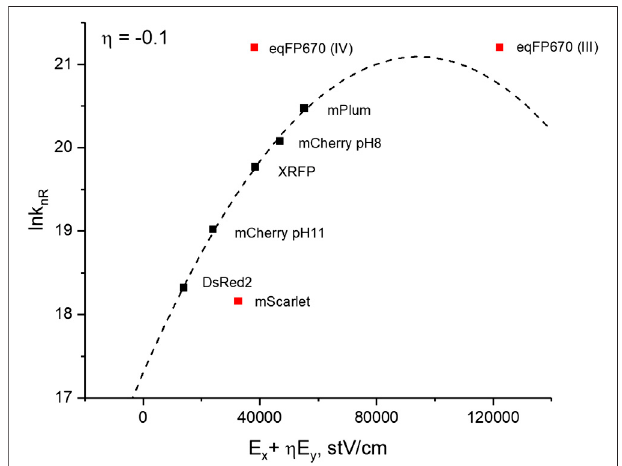
FIGURE8| Dependenceofnonradiativedecayrate(inlogarithmicscale) on the change of electrostatic potential energy normalized to the product of charge displacement along x -direction ( Δ x ) and the value of charge ( q ). Theoretical fi t of the model function Eq. 33 to the data obtained for fi ve proteins(blacksymbols)isshownbydashedline.mScarletandeqFP670data points (red squares) are not included in the fi t (see text). Red square labeled eqFP670 (IV) correspond tothe electric fi eld calculated from the Δ μ position in quadrant IV, and eqFP670 (III) — to Δ μ position in quadrant